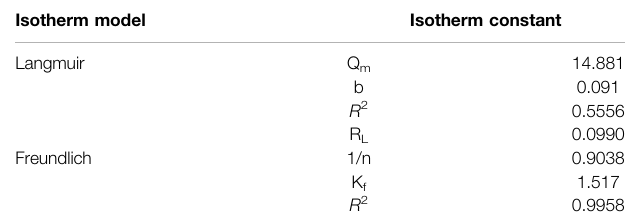
TABLE 2 | Isotherm parameters for the adsorption of malachite green over synthesized bionanocomposite. Isotherm